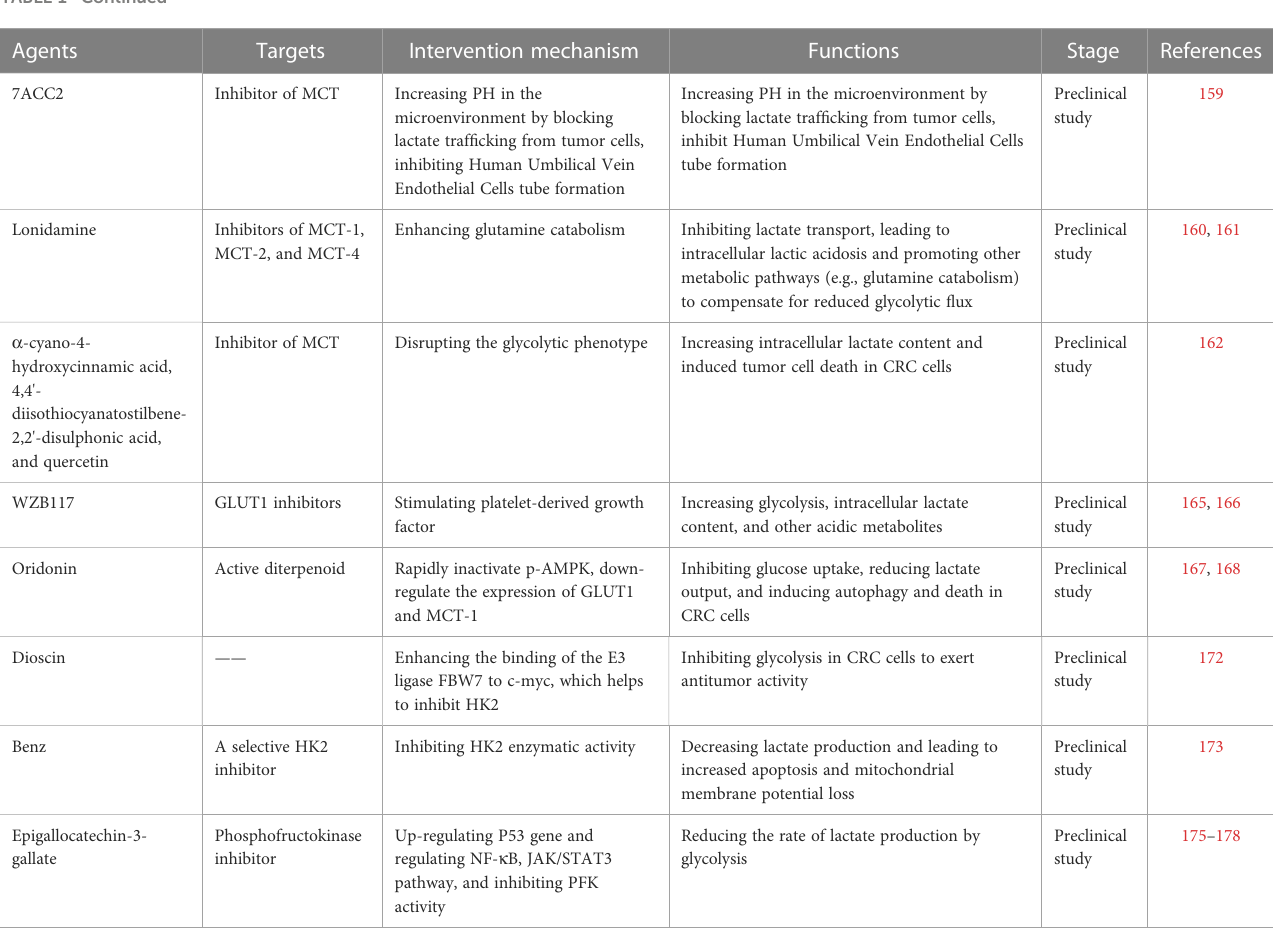
Phase 1 clinical trials and is entering the expansion phase of the